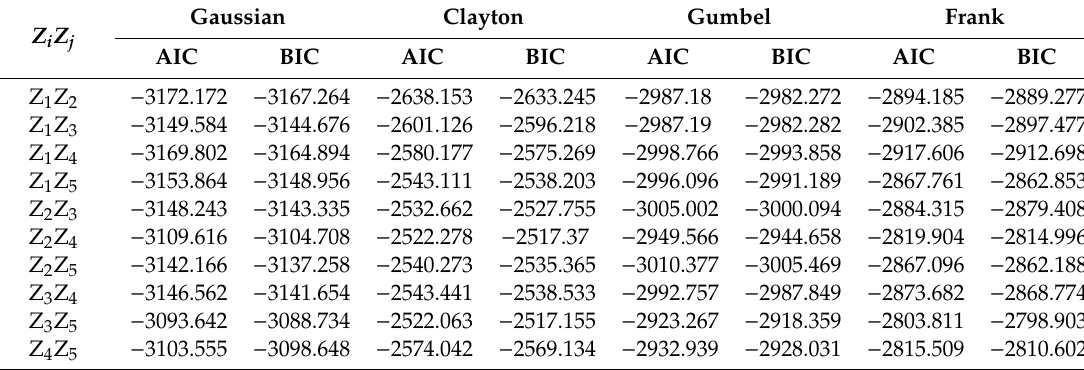
Table 6. The Akaike information criterion (AIC) and Bayesian information criterion (BIC) values for the candidate copulas.